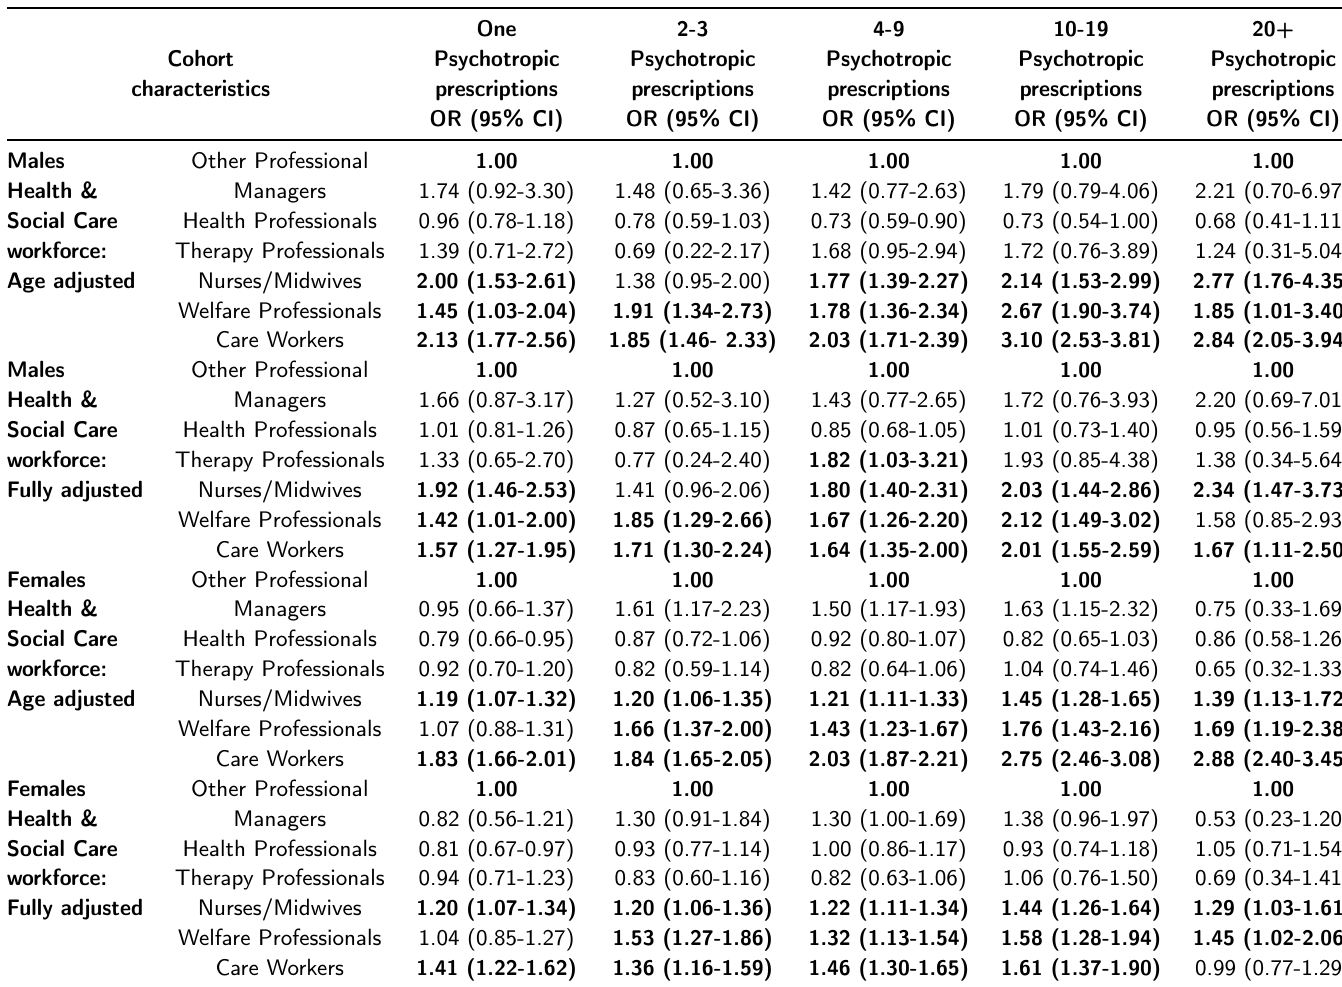
Table 3: Health and social care occupations and the likelihood for psychotropic prescriptions in the 12 months following the